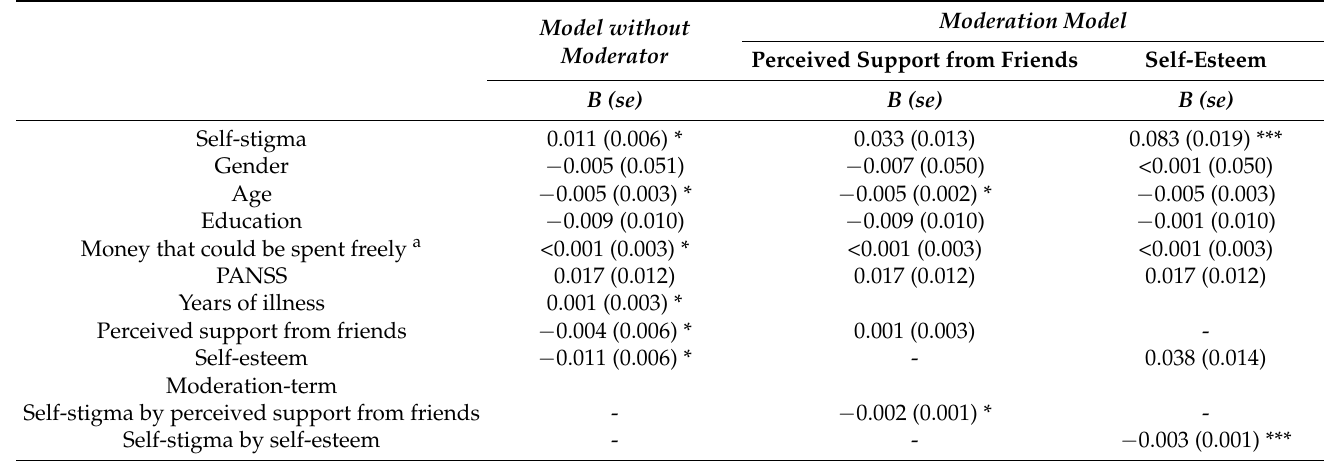
Table 2. Moderating effects of self-esteem and perceived support from friends on the association between self-stigma and suicide risk among individuals with schizophrenia. Model without